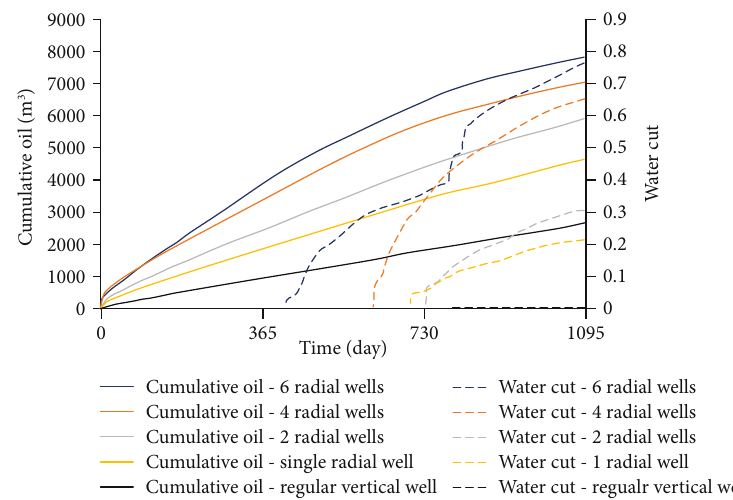
Figure 16: Variation of cumulative oil and water cut on